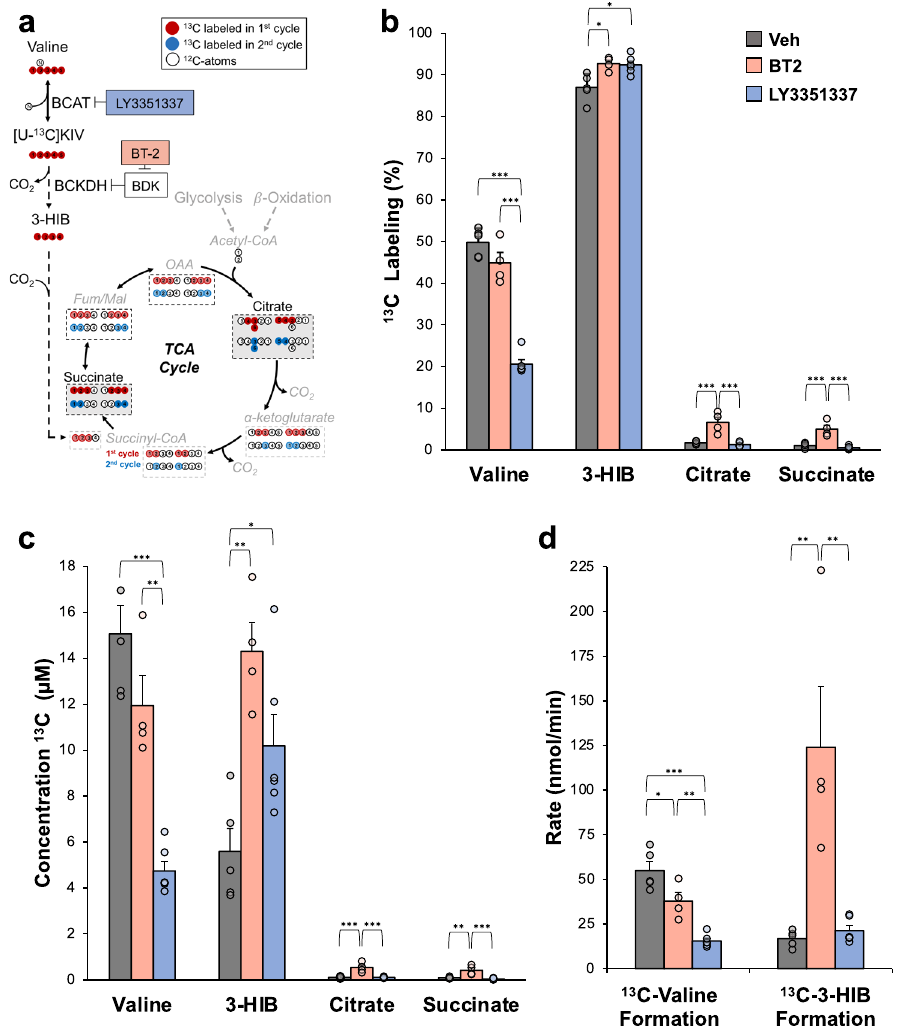
Fig. 1 Preferential reamination of α -ketoisovalerate (KIV) to valine in the isolated perfused heart. a Simpli fi ed schematic fi gure diagraming the potential metabolic fates of [U- 13 C]KIV, as well as the effects of LY3351337 to inhibit BCAT activity, and BT2 to inhibit BDK. Label incorporation from fi rst (red circles) and second (blue circles) passes through the TCA cycle are shown in dashed boxes. Measured metabolites in the TCA cycle are highlighted with a gray background and black dashed border. b The fractional percent labeling with 13 C is shown for the indicated metabolites; ( c ) The absolute amounts of 13 C- labeled valine, 3-HIB, citrate, and succinate are shown. Data in b – d are from hearts isolated from Wistar rats and perfused with [U- 13 C]KIV (100 μ M) in the absence (Veh; n = 5; gray) or presence of the BDK inhibitor, BT2 ( n = 4; red) or the BCAT inhibitor, LY3351337 ( n = 6; blue). d Rate of reamination (nmol/ min) of [U- 13 C]KIV to valine and rate of formation of 13 C-labeled 3-HIB from [U- 13 C]KIV in isolated hearts following treatment with LY3351337 or BT2. Data represent mean ±SEM. Statistical differences indicated by Tukey ’ s HSD post-hoc test following one-way ANOVA: * P < 0.05, ** P < 0.005, *** P <